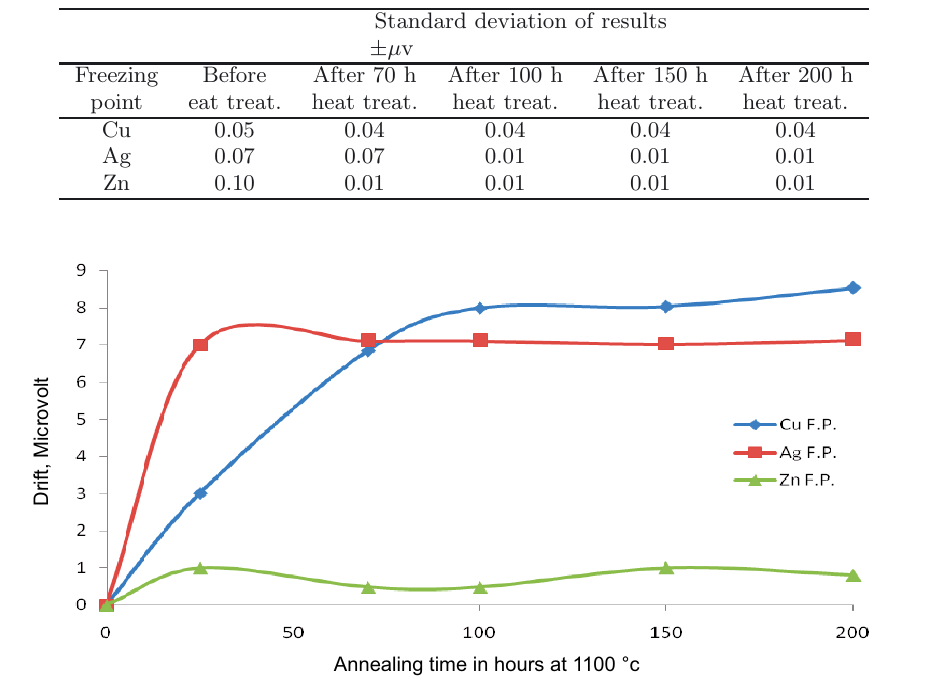
Table 1. Short term stability of Pt/Pd thermocouple by heat treatment at 1100 ◦ C, expressed as standard deviation, using Cu, Ag and Zn freezing points.